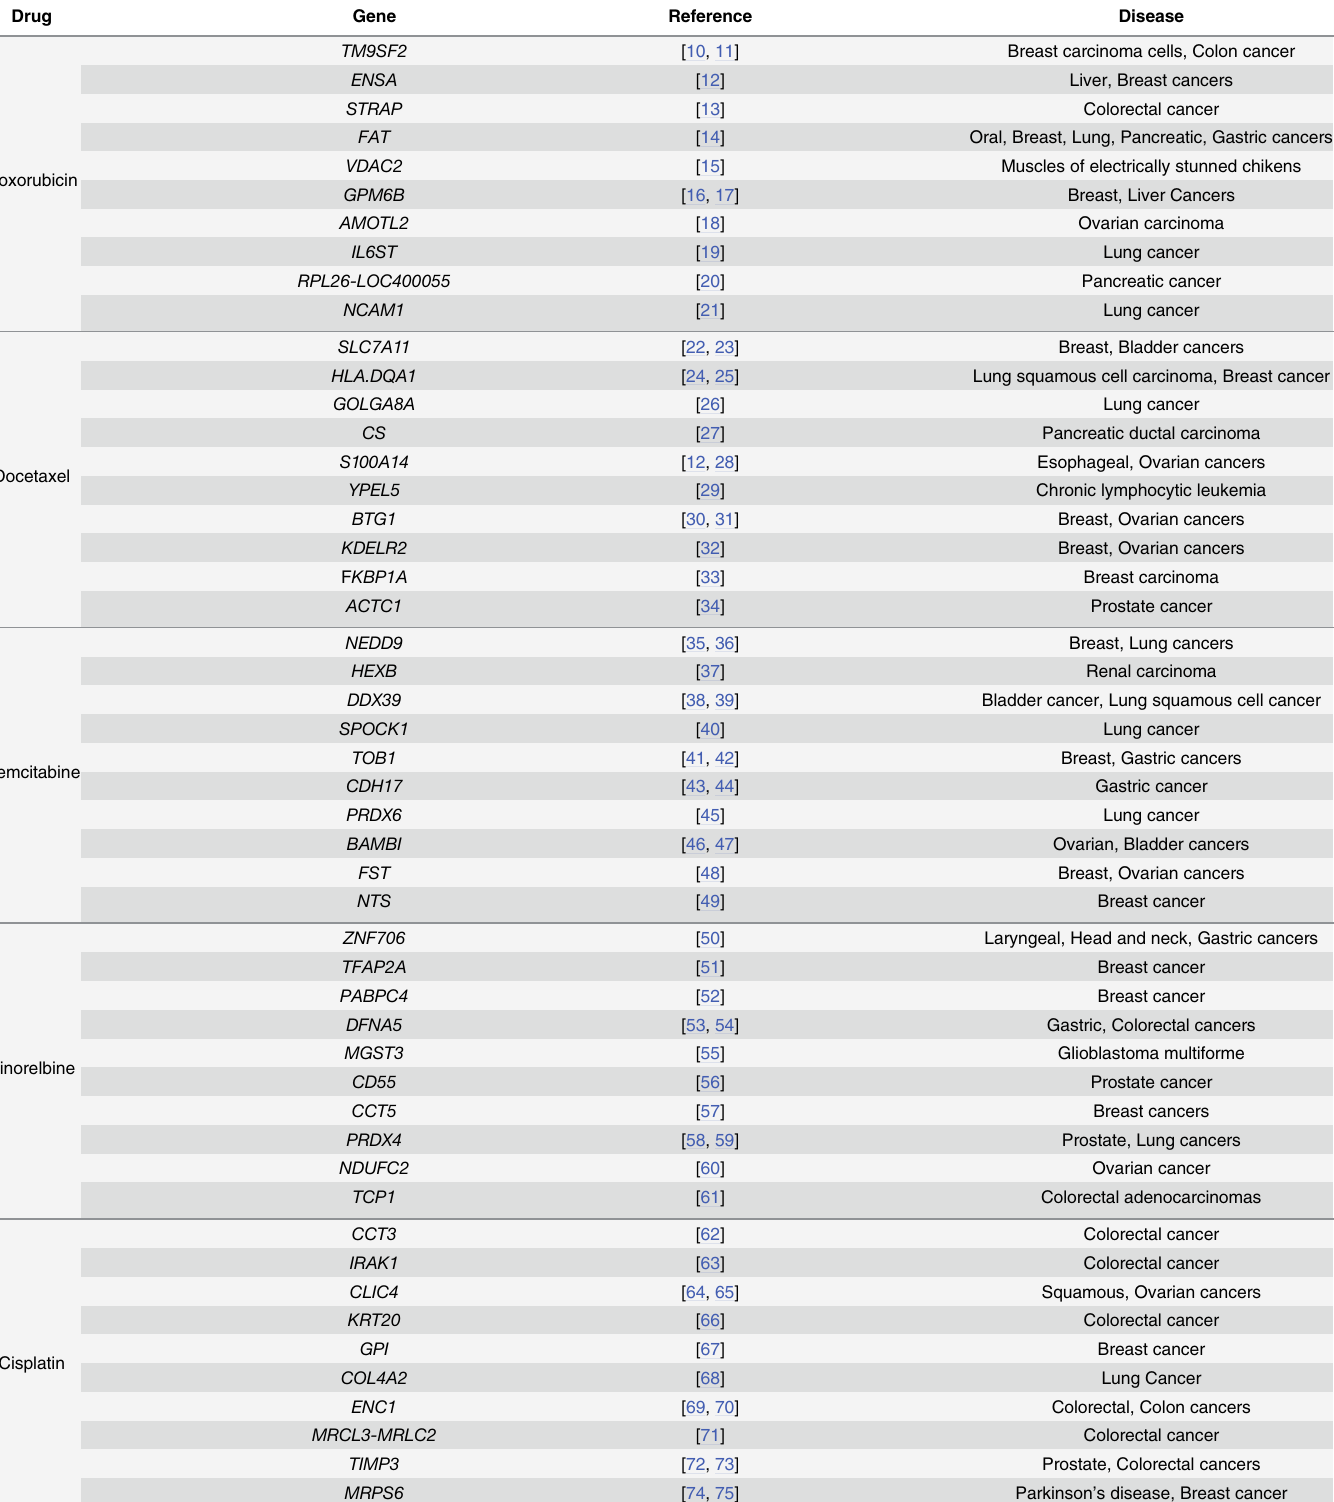
Table 4. Identified potential driver genes of anti-cancer drugs and their